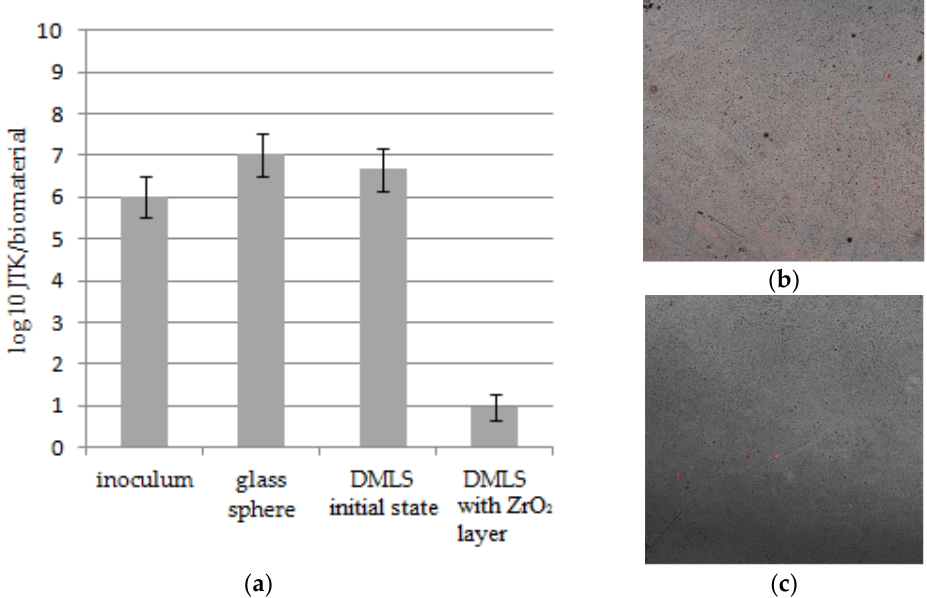
Figure 10. The number of S. aureus colony forming units: ( a ) obtained from the solution after sonication of the samples and remained on the surface of the material after sonication. Data are presented as mean ± SD. Statistical differences: Student’s t -test, α = 0.05, ( b ) Direct Metal Laser Sintering (DMLS) sample—initial state, ( c ) DMSL sample—with ZrO 2 layer (red color—adhered S. aureus bacterias).